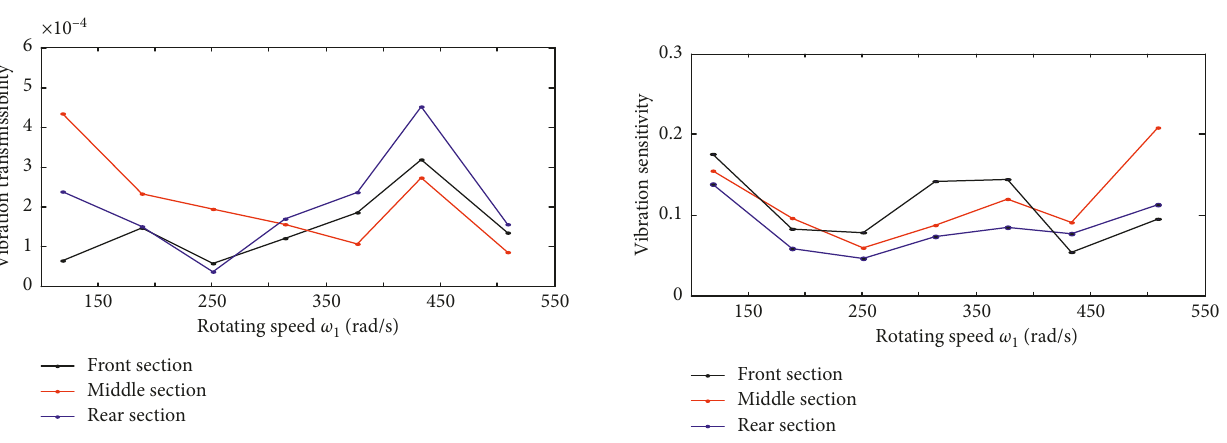
Figure 21: Experimental vibration transmissibility ξ with varying rotating speed of low-pressure rotor ω l : front section (black), middle section (red), and rear section (blue).